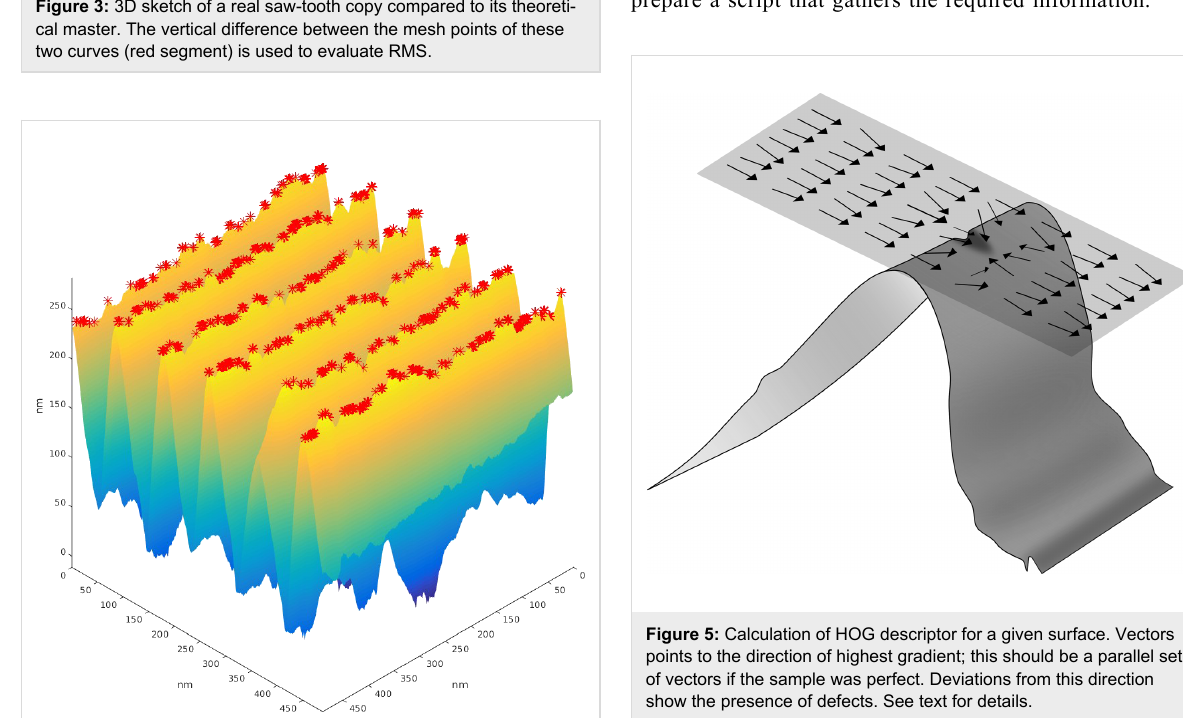
First, the gradients of a chosen point (actually, every pixel) of the surface with respect to its closest neighbors are